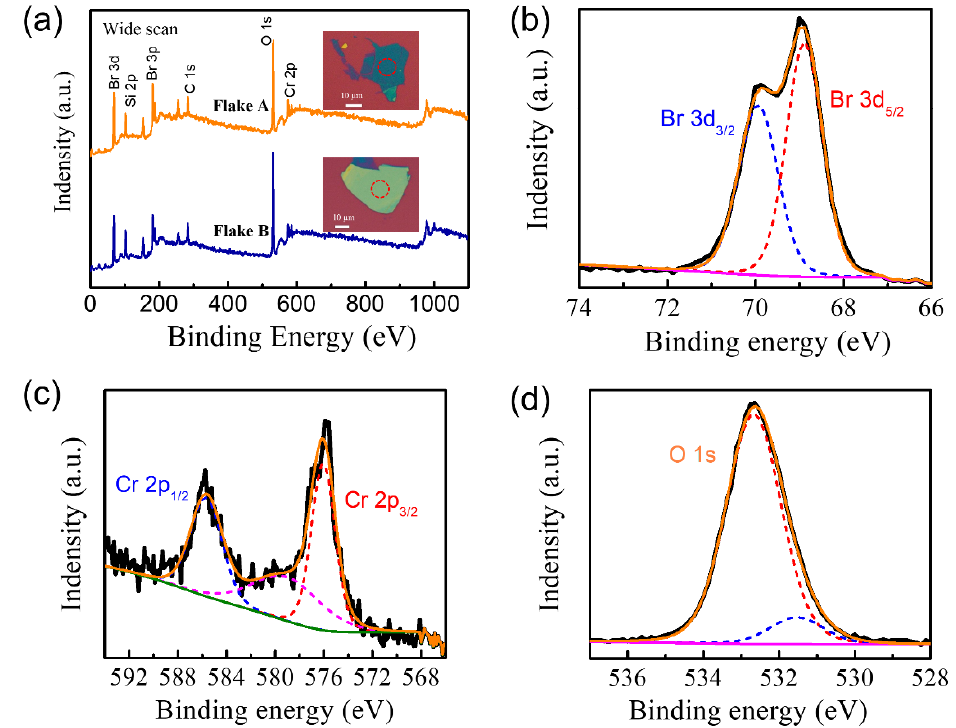
Figure 2. XPS spectra of CrBr 3 flakes exfoliated on SiO 2 /Si substrates. ( a ) A wide scan of two CrBr 3 flakes. Inset: the optical images of CrBr 3 flakes. ( b – d ) The fine scans of Br 3 d , Cr 2 p , and O 1 s of flake A, respectively. The dotted lines indicate the deconvoluted curves of Br 3 d , Cr 2 p , and O 1 s spectra. The two red circles in ( a ) indicate the location of the respective XPS measurements.